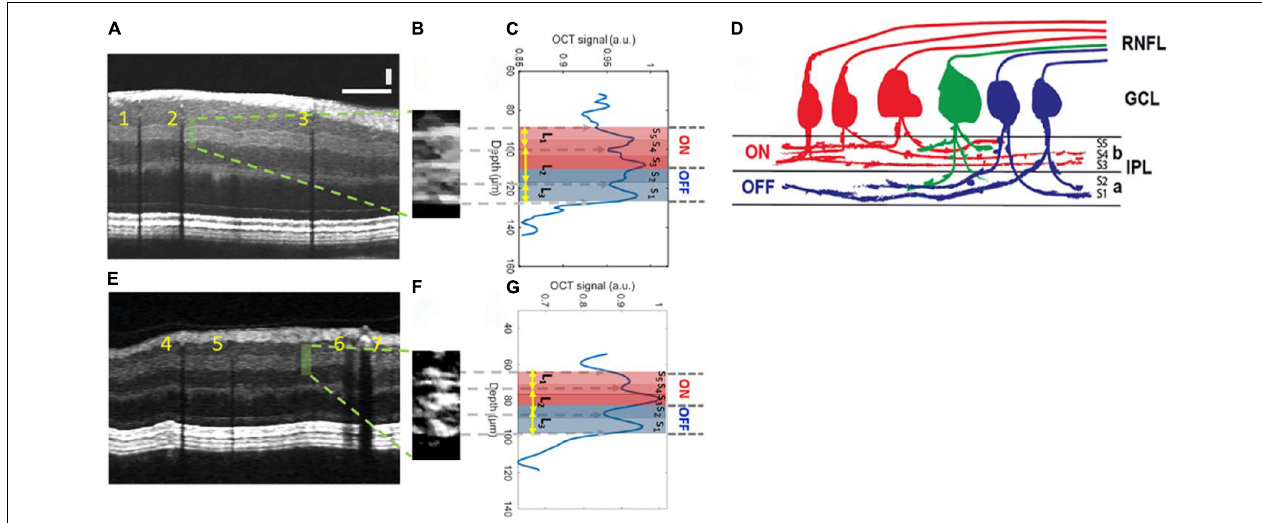
FIGURE 2 | Inner plexiform layer (IPL) sublayer visualization with Vis-OCT. (A) A speckle-reduced vis-OCT image from a healthy eye. A horizontal bar: 500 µ m; a vertical bar: 50 µ m. (B) A magnified view of the region highlighted by the dashed box in (A) (15 srA-lines segments). (C) A depth-resolved OCT amplitude profile of the IPL sublayers. We averaged 15 srA-lines, corresponding to approximately 88 µ m along the lateral direction within the highlighted region in (A) . (D) Illustration of the lamination of ganglion cells from RNFL to the IPL. The “red” ganglion cells (ON center) are laminating dendrites to the “b” sublamella of the IPL whereas “blue” cells (OFF center) laminate to the “a” sublamella. The “green” ganglion cell is bi-laminating. (E) A speckle-reduced vis-OCT image from a glaucoma eye. (F) A magnified view of the region highlighted by the dashed box in (E) . (G) A depth-resolved line profile of the glaucoma eye IPL sublayers. This figure was reprinted